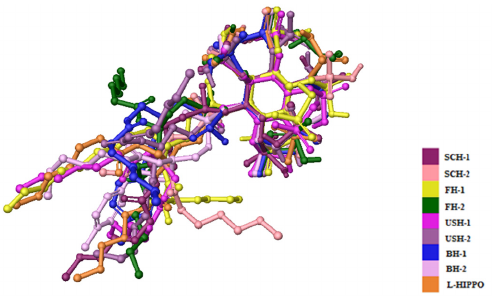
Figure 4. Alignment of eight new L ‐ HIPPO derivatives (SCH ‐ 1, SCH ‐ 2, FH ‐ 1, FH ‐ 2, USH ‐ 1, USH ‐ 2, BH ‐ 1, and BH ‐ 2) in the MA domain (PDB ID: 7E1I).